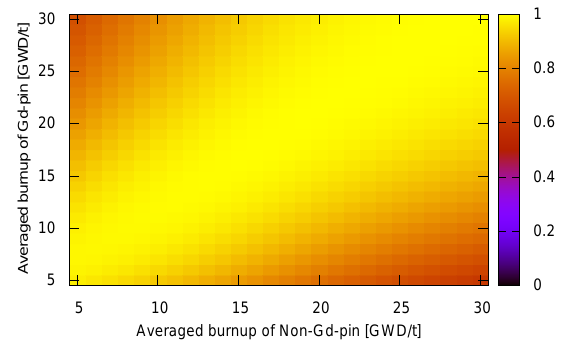
Figure 9. Correlation matrix of Am-241 number density uncer- tainty between the Gd-bearing and non Gd-bearing rods